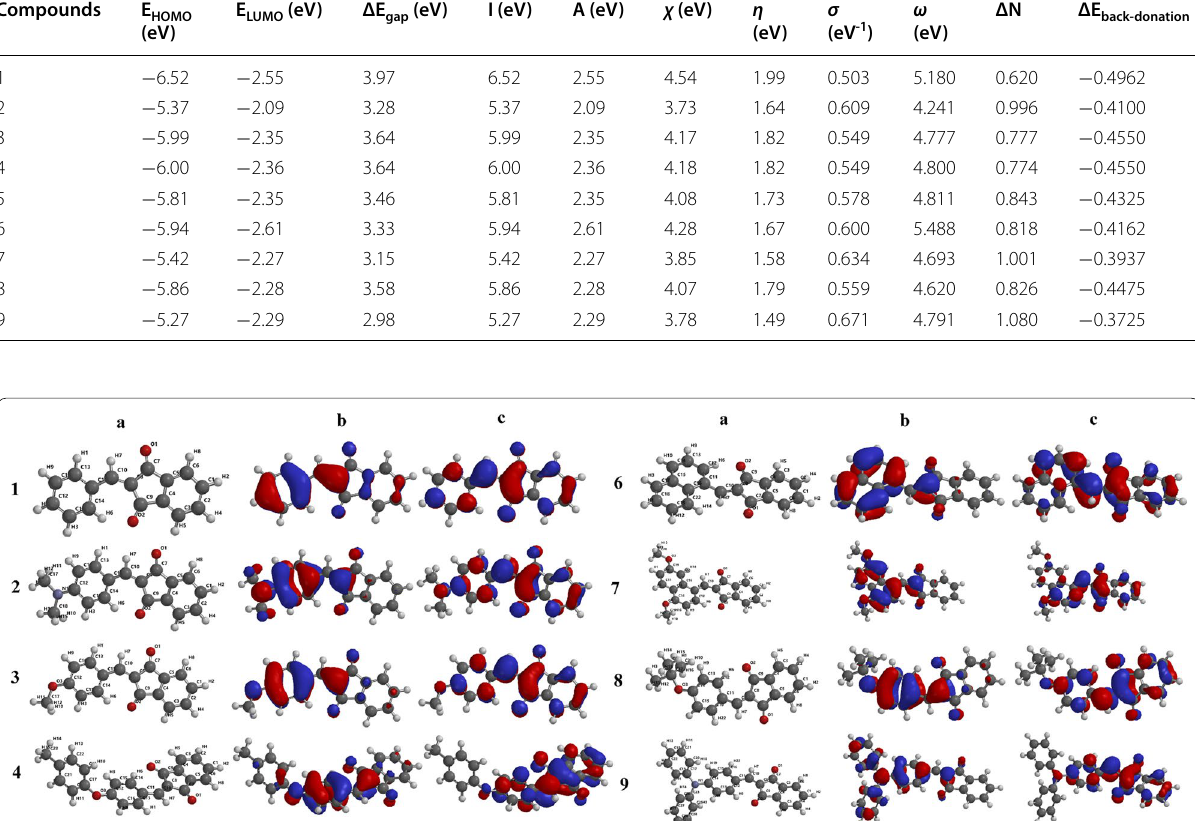
Table 1 The calculated quantum chemical parameters with DFT/B3LYP/6-31G(d) method Compounds E HOMO (eV)